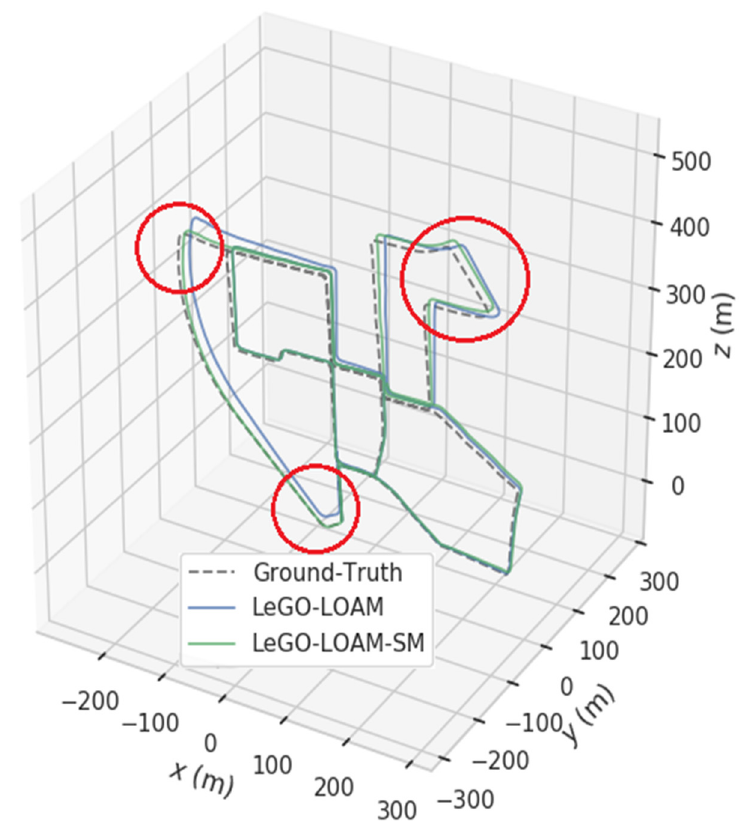
Figure 6. Comparison of the motion trajectories of LeGO-LOAM-SM and LeGO-LOAM.